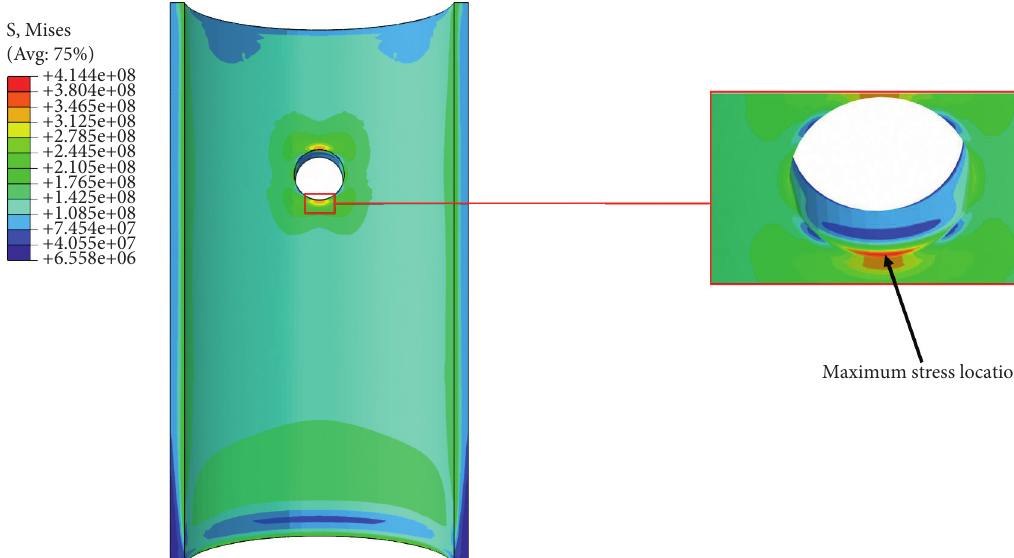
Figure 5: Maximum stress concentration area at the inlet nozzle-inside vessel wall intersection of the FE model.